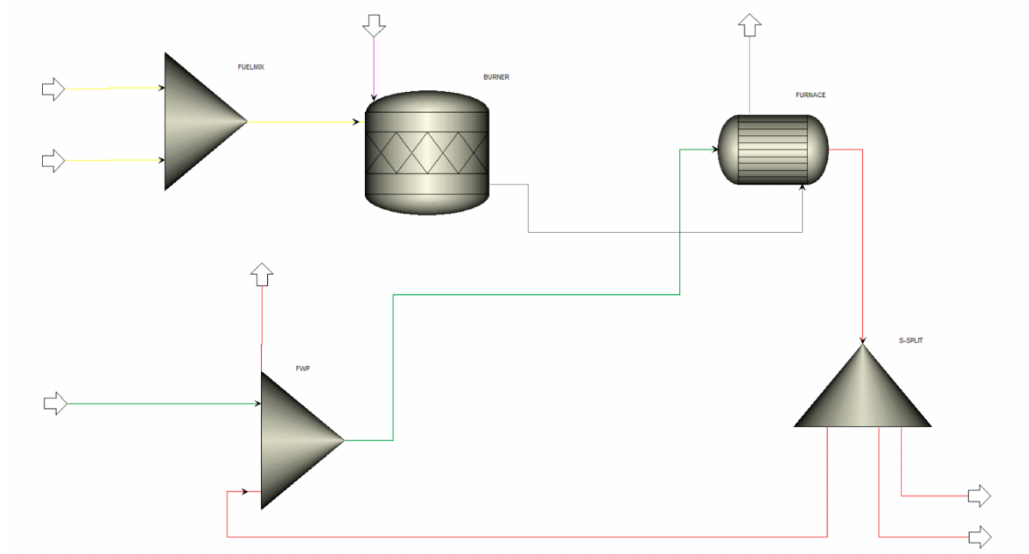
Figure 4. Aspen Plus process flowsheet of boiler room (color specification of streams compatible with Figure